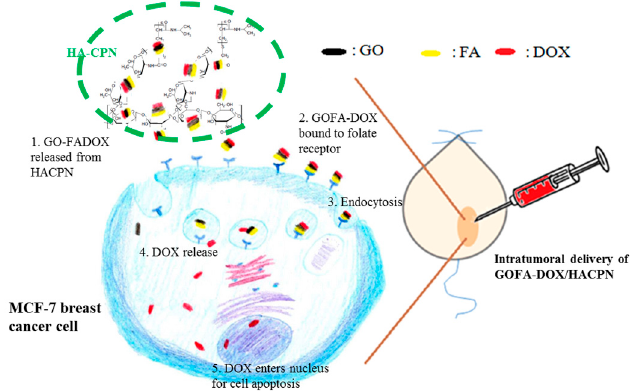
Figure 1. The schematic illustration of the antitumor effect by intratumoral delivery of DOX-loaded GOFA in HACPN hydrogel (GOFA-DOX/HACPN) in a xenograft tumor mouse model with MCF-7 cells implanted subcutaneously in nude mice.